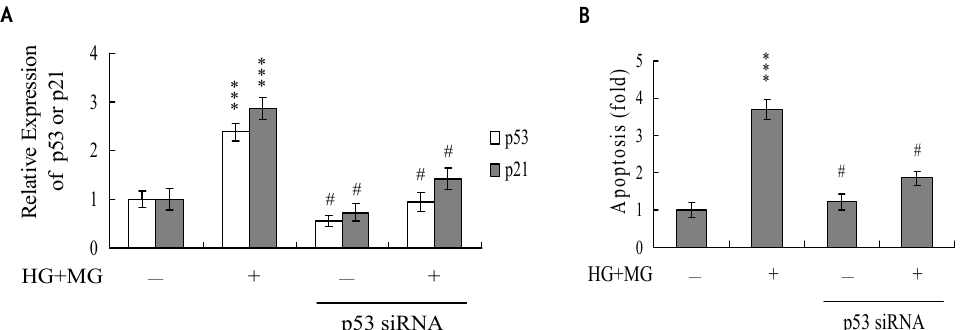
Figure 7. Knockdown of p53 protects HMNCs against MG/HG-induced